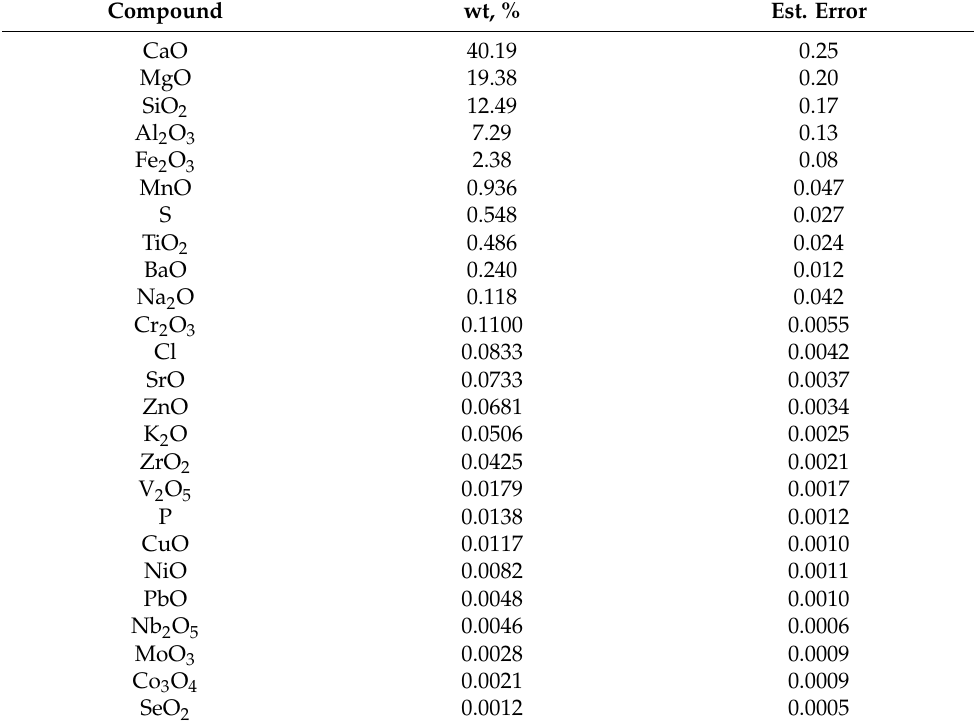
Table 5. Results of the X-ray fluorescence of ladle furnace